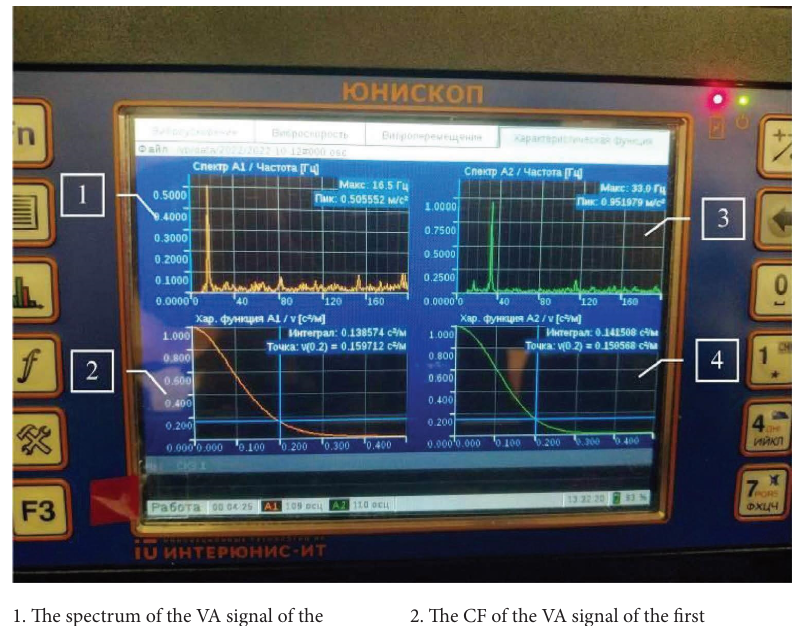
Figure 6: UNISCOPE device